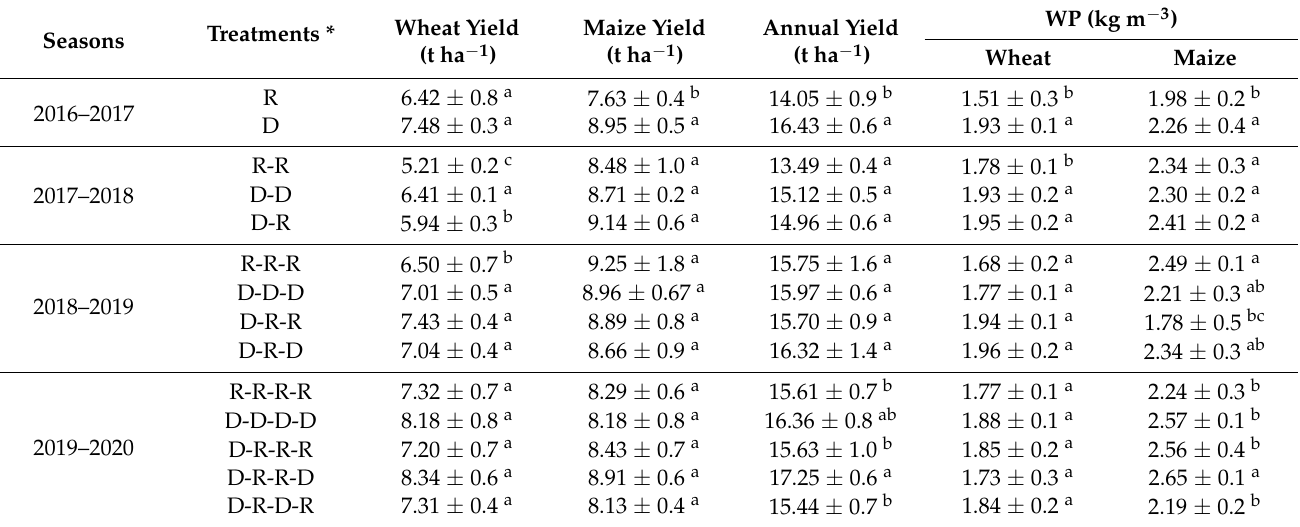
Figure 4. Soil water depletion for different treatments during the winter wheat season of 2016 to 2020 (R representing rotary tillage, D representing deep tillage, and their arrangements representing the different combinations in each year. Different lowercase letters in the same column mean significant differences among treatments at 0.05 level. LSD test: p < 0.05). Table 7. Grain yield and water productivity (WP) for winter wheat and summer maize for different treatments, from 2016 to